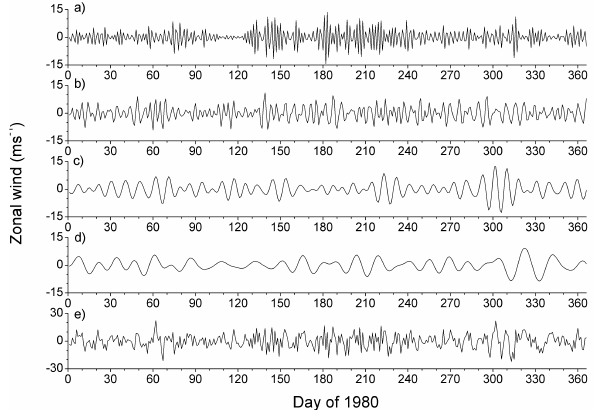
Fig. 1. Examples of time series of daily zonal (positive eastward) and meridional (positive northward) winds during 1980.